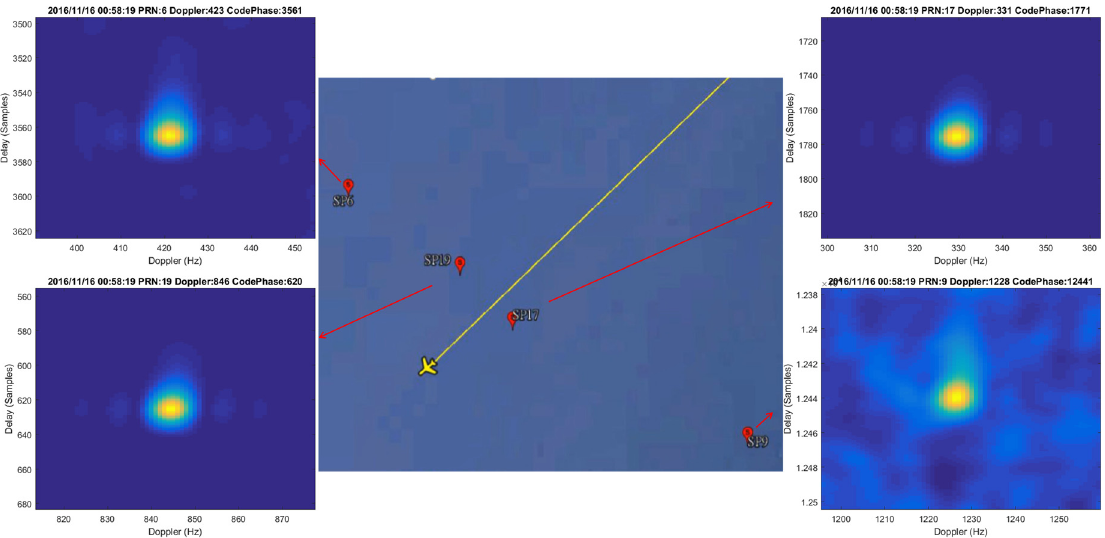
Figure 10. One snapshot of the aircraft position, four specular point positions (red points) and four corresponding